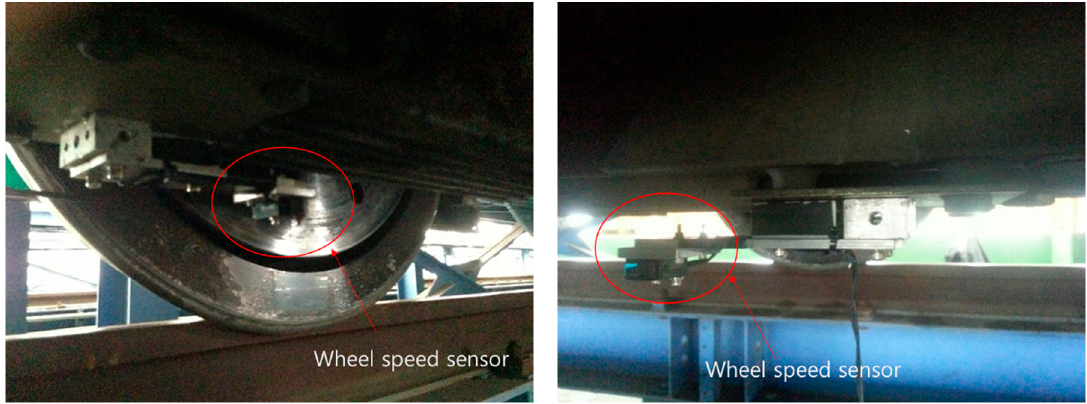
Figure 6. The reflective-type laser wheel speed sensor on the bogie.